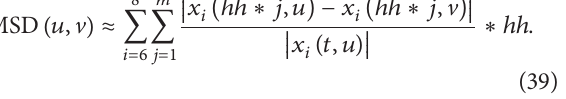
Algorithm 1. Particle swarm optimization